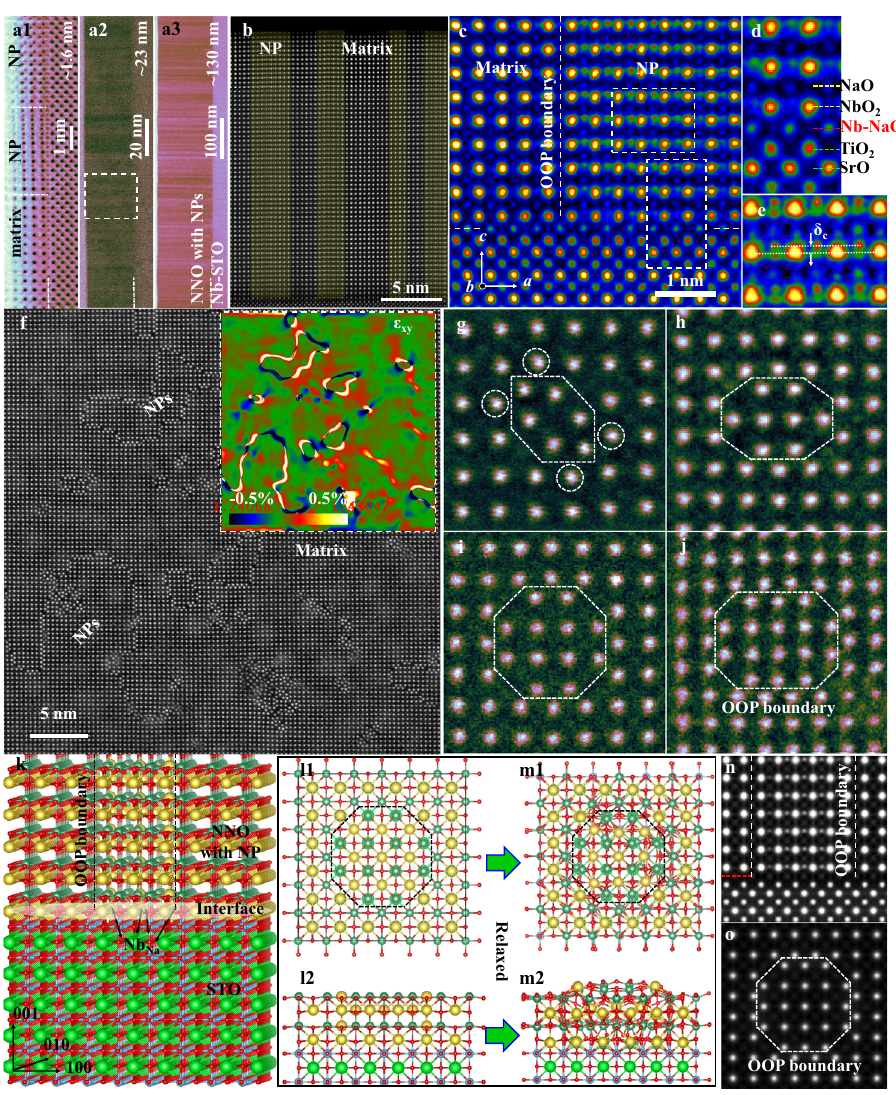
Fig. 2 Structural imaging of NP-NNO thin fi lms. a1 – a3 STEM ABF images of the NP-NNO/STO fi lm grown with thickness of ~4 uc, ~23 nm, and ~130 nm, respectively. b High-magni fi cation STEM HAADF image showing an overall view of the NP-NNO/STO fi lm shown in a2 . c Atomically resolved STEM HAADF image showing one OOP boundary and the NNO/STO interface. d Enlarged image from b focusing on the interface. e Enlarged image from c focusing on the nanopillar. f High-magni fi cation plan-view STEM HAADF image of NP-NNO/STO showing a high density of nanopillars, with a strain analysis result inset. g – j Enlarged STEM HAADF images of one nanopillar with 6, 8, 12, 16 Nb atoms, respectively. k The 3D structural model with one polar nanopillar and the NNO/STO interface. l1 , l2 and m1 , m2 Initial and relaxed structural model of one polar nanopillar with 12 Nb atoms and the NNO/STO interface, viewed along [001] (plan view) and [100] (cross-section view) axes. n , o Simulated STEM HAADF images of NP-NNO/STO with one